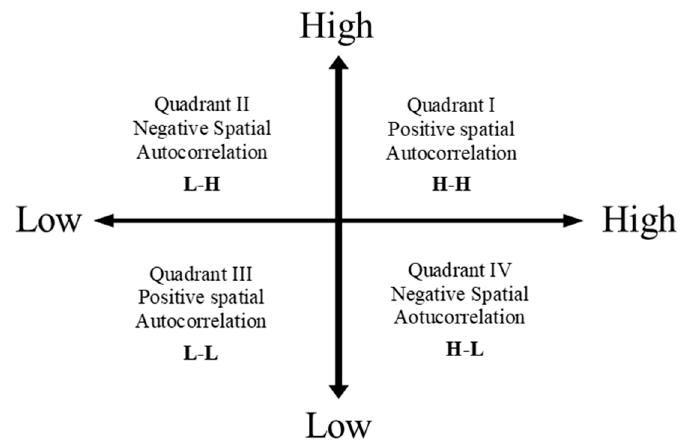
Figure 2. Spatial autocorrelation of the local indicators of spatial association (LISA) analysis.